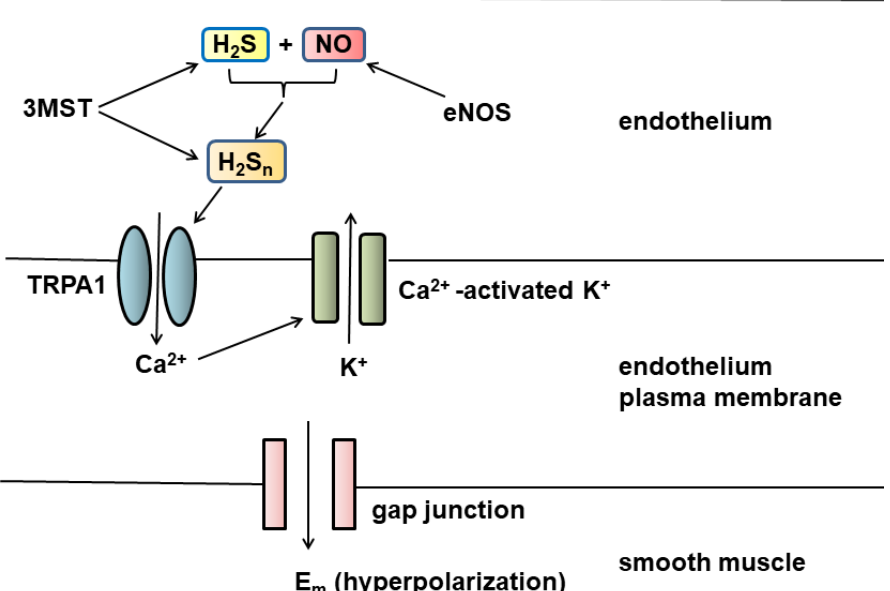
Figure 1. H 2 S n are potential EDHFs. Both 3MST and eNOS are localized to endothelium. H 2 S n produced by 3MST or by the chemical interaction between H 2 S and NO activate TRPA1 channels present in myoendothelial junctions to induce Ca 2+ influx, which activates Ca 2+ -dependent K + channels. The change in membrane potential is conducted via gap junction to hyperpolarize the smooth muscle plasma membrane.